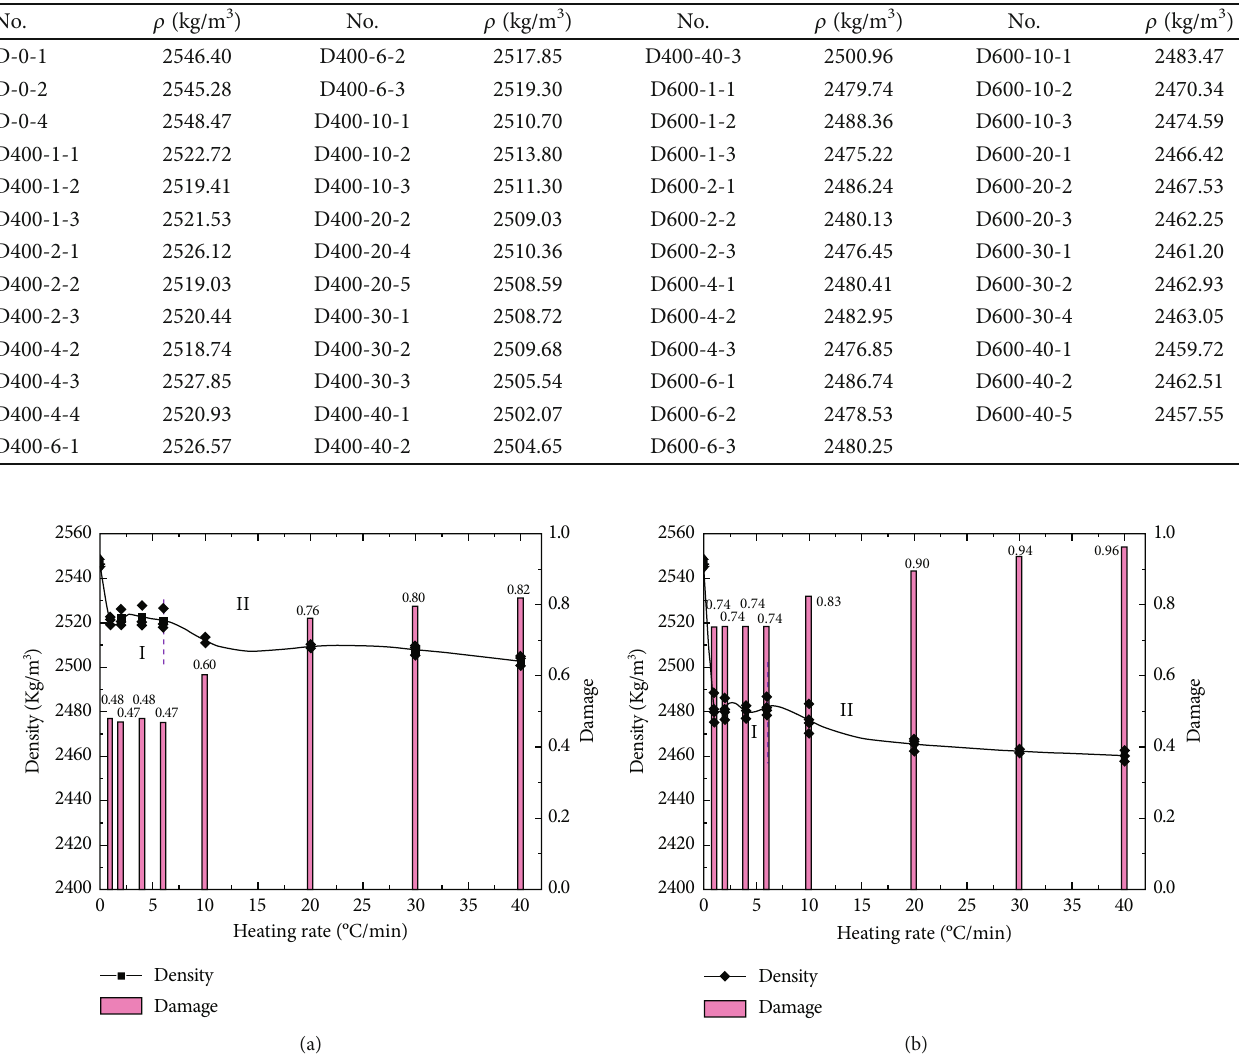
Figure 8: Damage e ff ect on the density of thermal shock treated granite specimens (a) T = 400 ° C and (b) T = 600 ° C